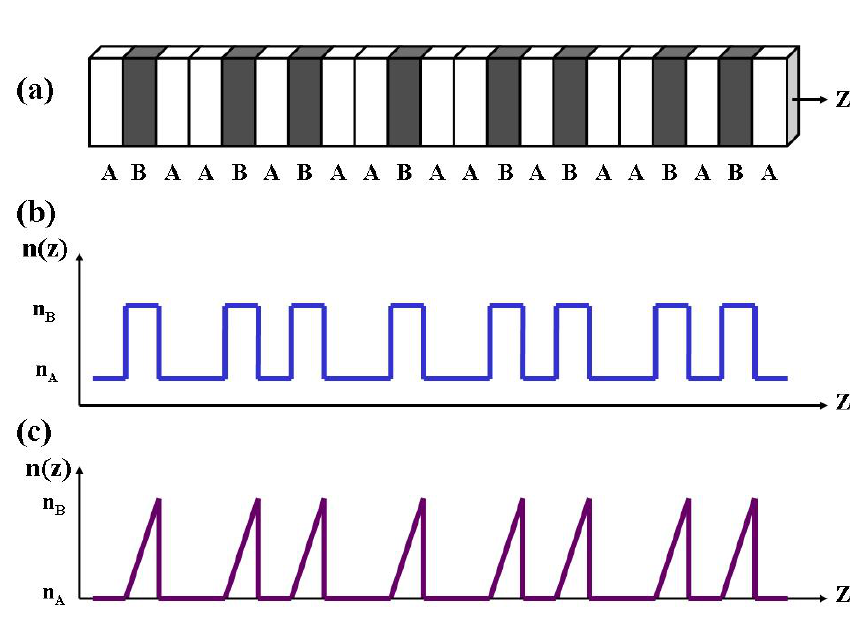
Figure 1. ( a ) Sketch of a Fibonacci dielectric multilayer grown along the z direction; ( b ) Refractive index profile n ( z ) for an arrangement of layers with constant refraction index; ( c ) Refractive index profile n ( z ) for an arrangement of layers with a linearly graded refraction